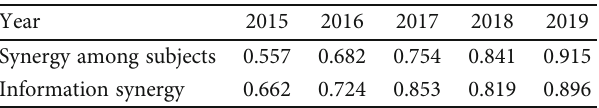
Table 4: Order degree of the CME management synergy decision- making subsystem in Henan Province.